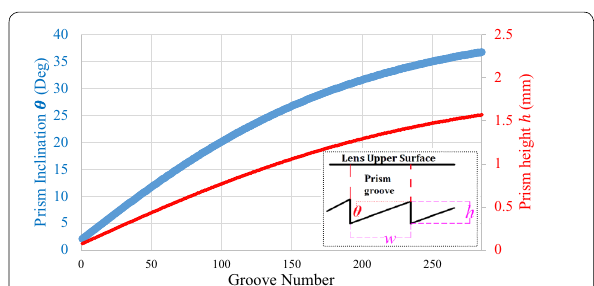
Fig. 5 Prism inclination (Blue: thick curve) and prism height (Red: thin curve) of the Fresnel lens calculated at the converging chromosome by Qandil and Zhao (2018) algorithm for the solar welding application